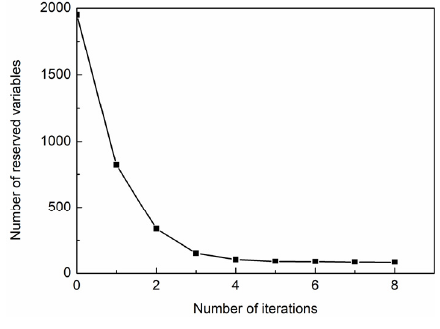
Figure 2. Number of retained variables.